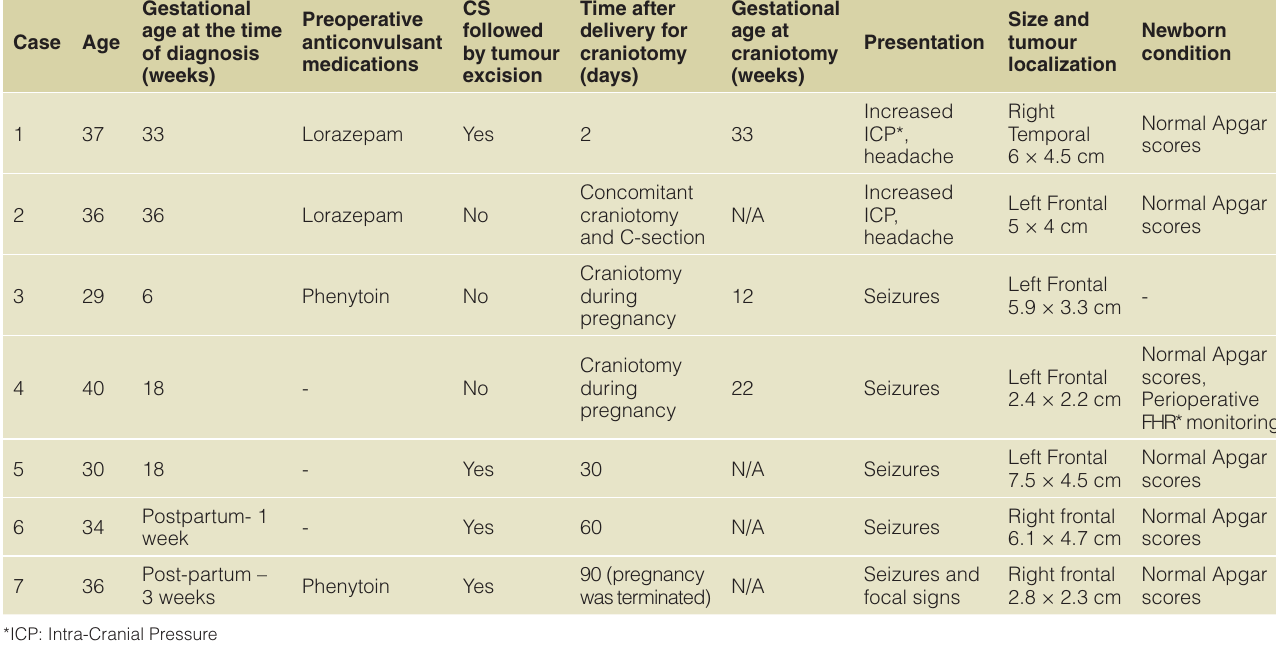
Table 2. Preoperative information of pregnant patients with brain tumours at the Cleveland Clinic, Ohio (2003–2008).